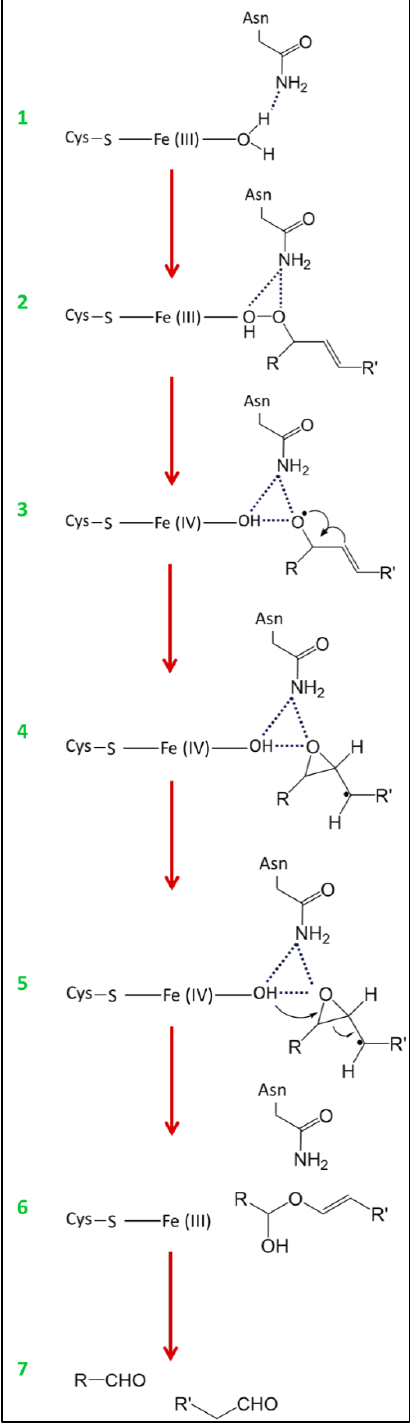
Figure 5. Schematic diagram of the proposed reaction mechanism of HPL [148]. In the absence of substrate, the iron atom of the heme is coordinated with a cysteine residue and a molecule of water which establishes hydrogen bonds with an asparagine residue (1). The substrate picks up the molecule of water (2). After cleavage of the O-O bond of the hydroperoxide function of the substrate (3), an epoxycarbinyl radical is generated (4). The formation of a double bond between the carbons 11 and 12 and the oxygenation of the carbon 13 (5) leads to the formation of a hemiacetal (6) which cleaves spontaneously into aldehyde and oxoacid (7). R and R’ represent the carbon chains, respectively, towards the methyl and carboxyl ends of the substrate.